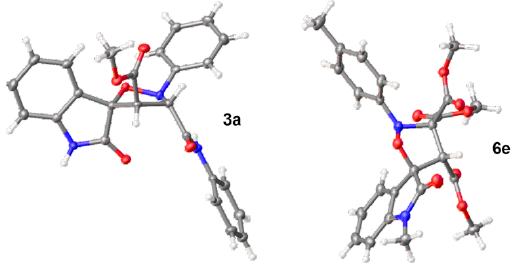
Figure 1. X-ray structures of products 3a and 6e